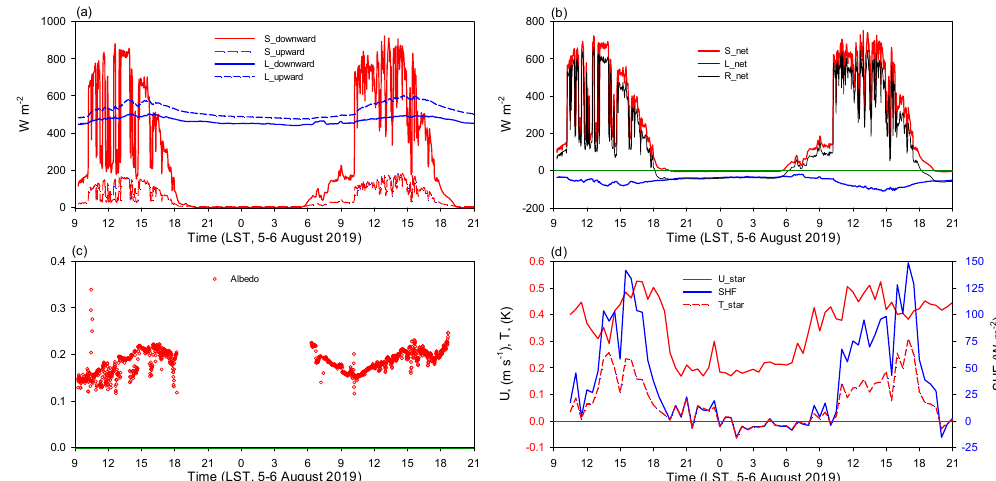
Figure 9. Time series of ( a ) 4-components radiative fluxes, ( b ) net shortwave, net longwave, and net global radiative fluxes, ( c ) albedo, and ( d ) friction velocity, friction temperature, and sensible heat flux observed at point A2 of Gwanghwamun Square during the BBMEX campaign